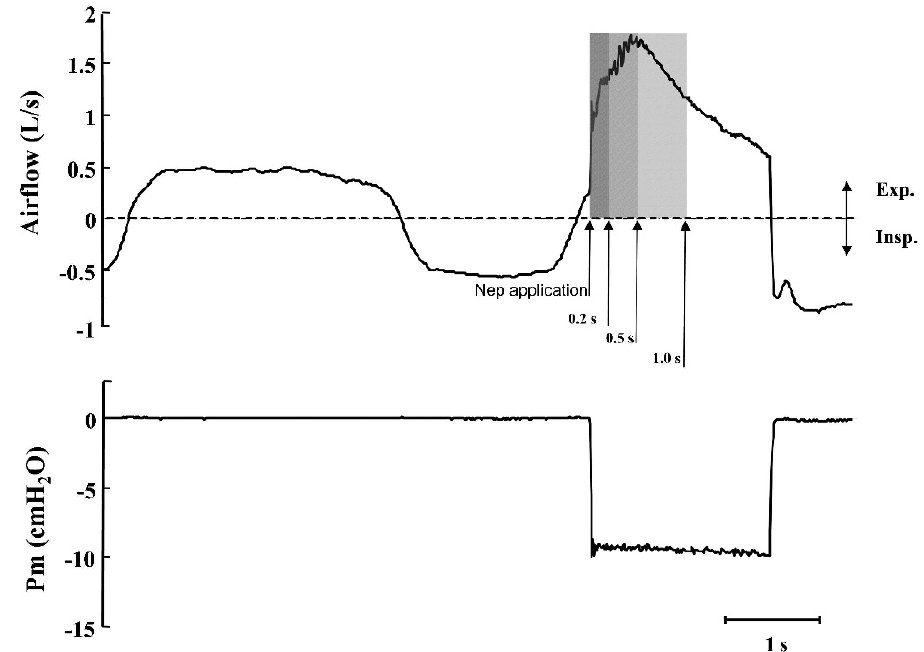
Figure 1 - Negative expiratory pressure (NEP) application during tidal expiration. Airflow and mouth pressure (Pm) during tidal respiration and NEP application. The hatched areas under the flow curve measure the expired volume at 0.2 s (V 0.2 ), 0.5 s (V 0.5 ), and 1.0 s (V 1.0 ) after NEP application. Insp: inspiration; Exp: expiration. Table 1 - Anthropometric and respiratory data of the subjects arranged by AHI.